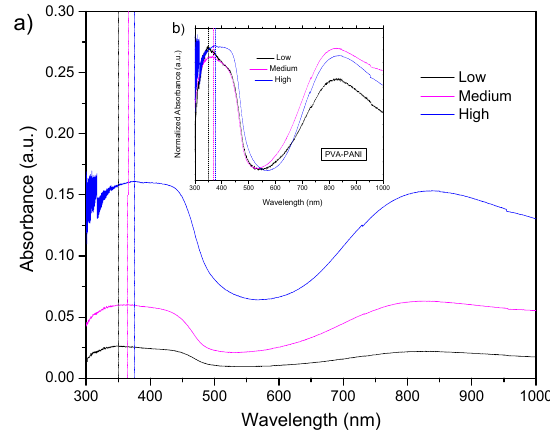
Figure 6. ( a ) UV–Vis-NIR absorbance and ( b ) normalized UV–Vis-NIR absorbance spectra of PVA–PANI thin films at low, medium, and high concentrations of PANI.